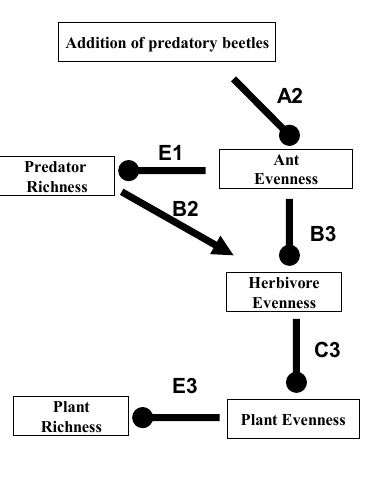
Figure 2. Diversity cascades in a tropical forest based on patterns uncovered by experiments and observational data [20,83,84]. Bullet-heads indicate a negative effect of an increase in one variable on another. One diversity cascade depicted here (A2 – E1 – B2 – C3) involved the increased dominance of a top predatory beetle that caused decreases in predatory ant dominance (A2), indirectly decreasing ant richness (via E1), decreasing herbivore evenness (via B2 and B3) and decreasing leaf area of one understory plant species, decreasing plant evenness (via C3). Another top-down diversity cascade in this system involved the same top-down effects, which resulted in in plant on poor soils (via